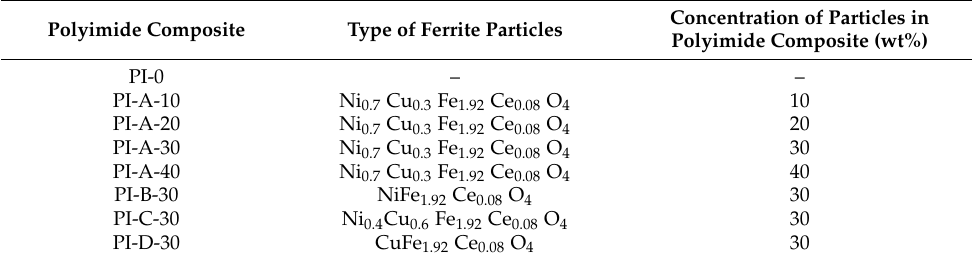
Table 2. Type and concentration of ferrite particles for each composite